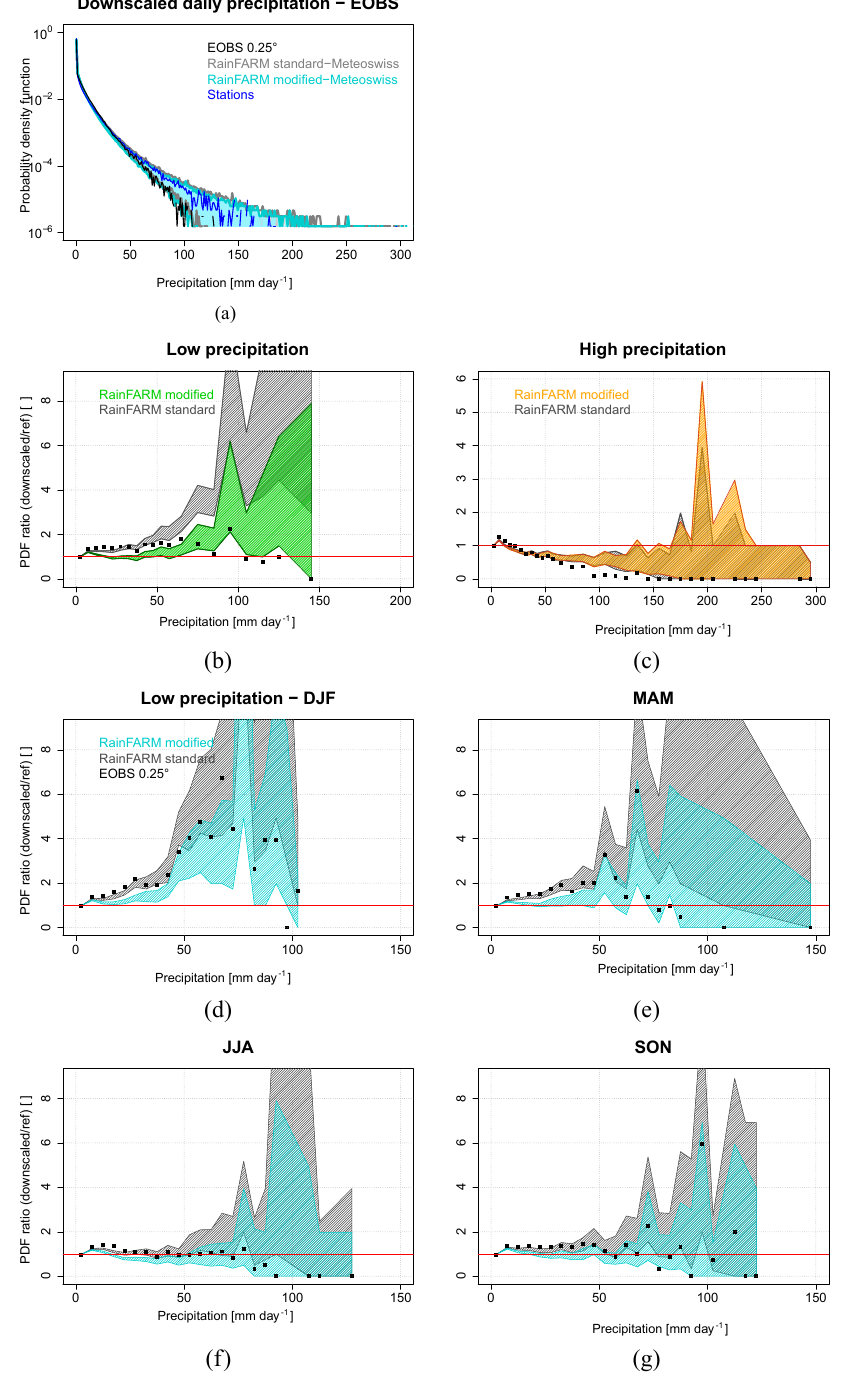
Figure 4. (a) The “real-case” experiment. Probability density function (PDF) of E-OBS daily precipitation at the original resolution of 0.25 ◦ (black), E-OBS precipitation downscaled using the standard (gray) and the modified (light blue) RainFARM with the MeteoSwiss weights, and the observations from 59 stations in Switzerland (dark blue). Gray and light-blue bands and lines represent the spread of the ensemble and the fifth and 95th percentile ranges, respectively, calculated from 80 realizations of the stochastic downscaled field. (b, c) The ratio between the PDFs of (i) E-OBS at its original resolution (black squares), (ii) 80 E-OBS downscaling realizations with the standard (gray) and the modified (colors) RainFARM, and the PDF of the observations, for low-precipitation (b) and high-precipitation (c) grid points. (d–g) Same as (b) but for different seasons (DJF, MAM, JJA, SON) and for low-precipitation grid